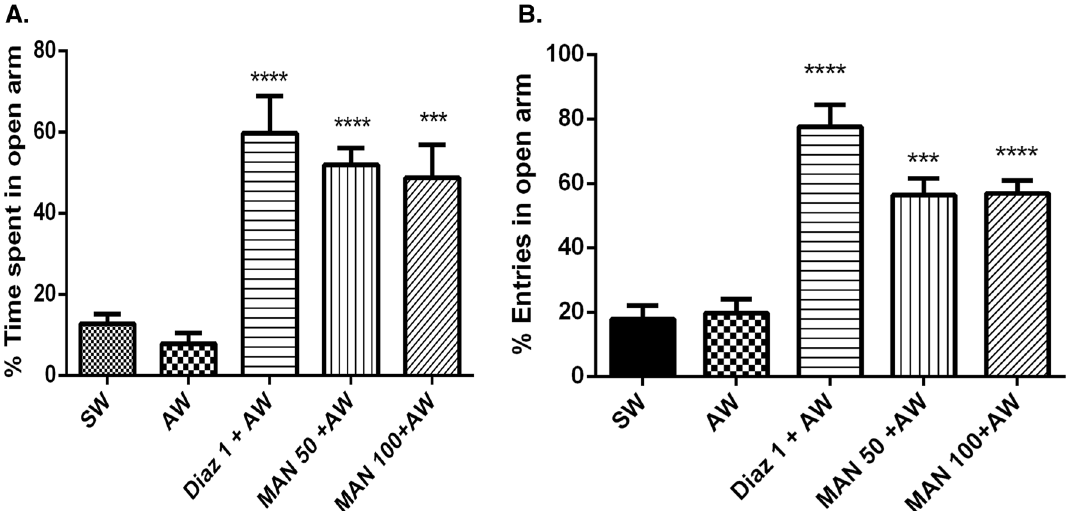
Fig. 3 Effect of MAN (50 and 100 mg/kg p.o.) on A % time spent in open arm, B % no. of entries in open arm in the EPM mouse model. The data were expressed as MEAN